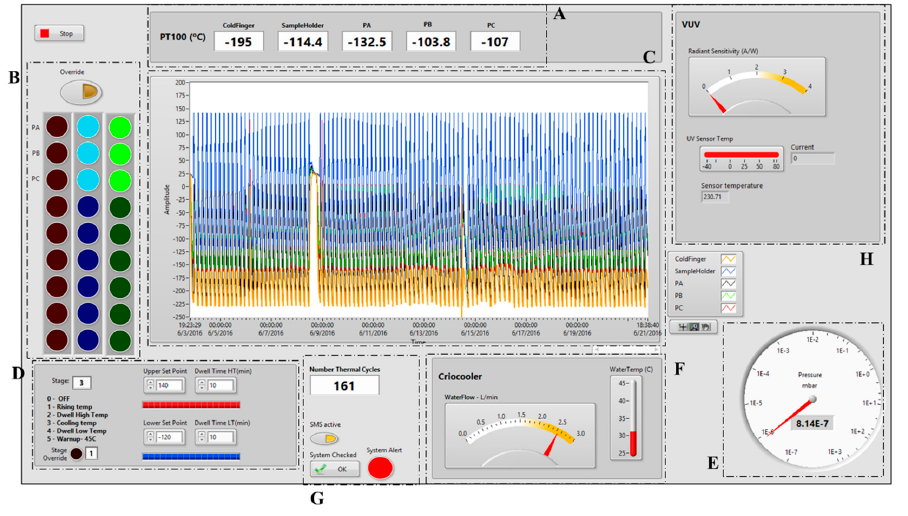
Figure 19. Interface of the control panel.